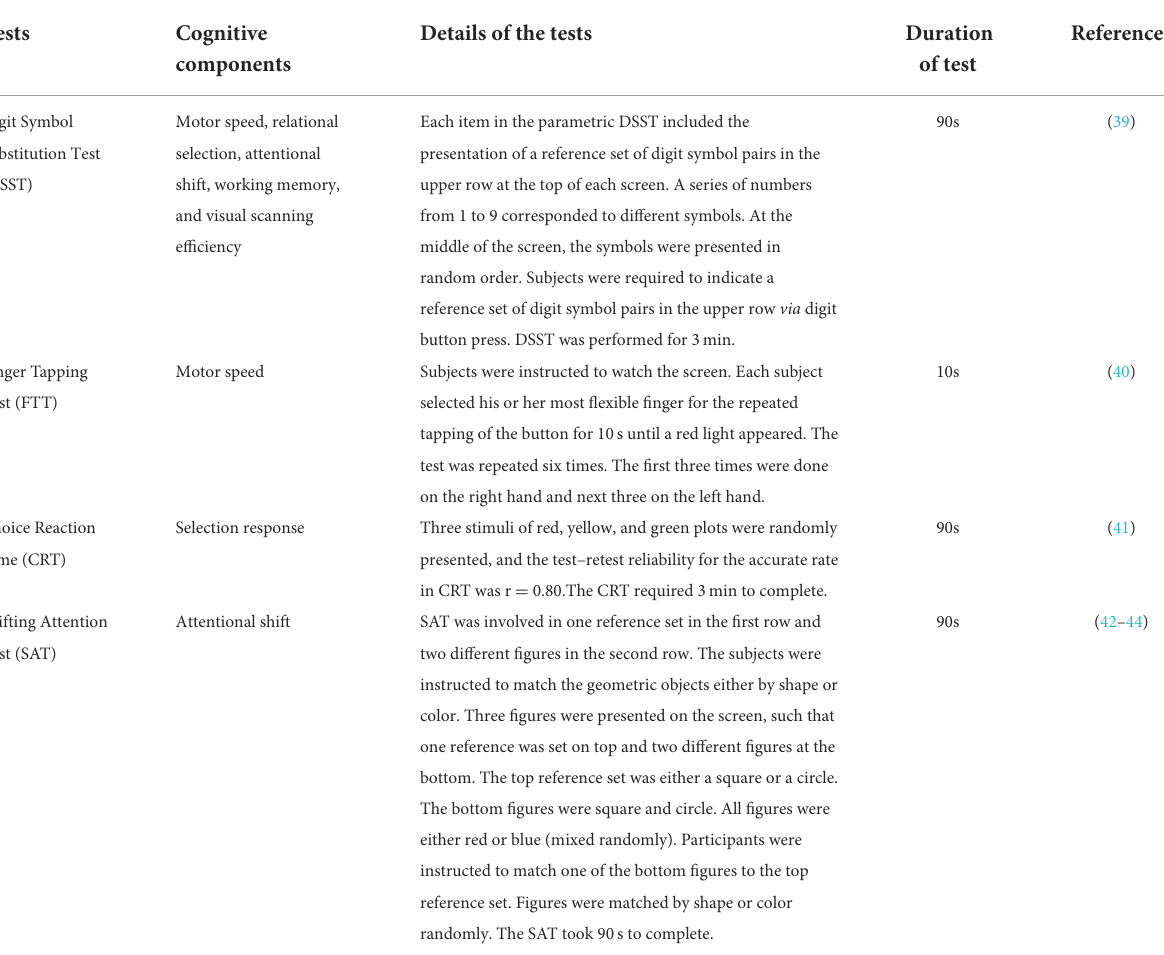
TABLE 1 Description of different cognitive